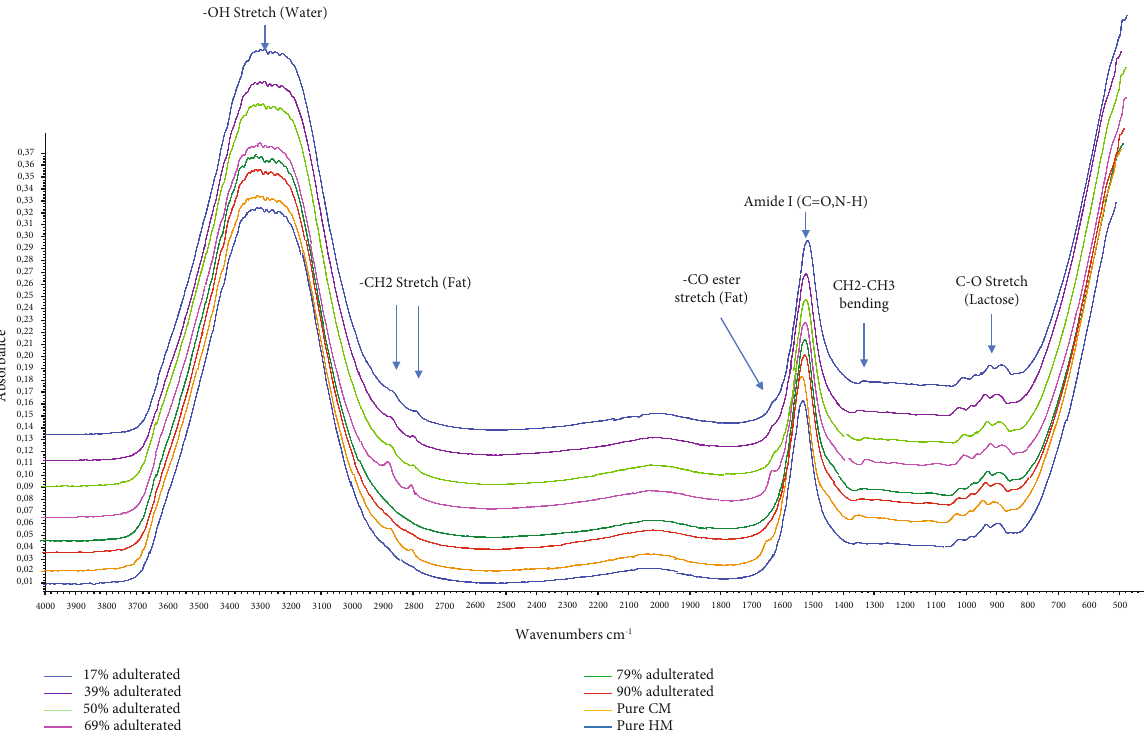
Figure 3: FTIR spectra of the binary mixture were selected from pure horse ’ s milk (HM), goat ’ s milk (GM), and adulterated milk (HM-GM) in the infrared region (4000-650cm -1 ).